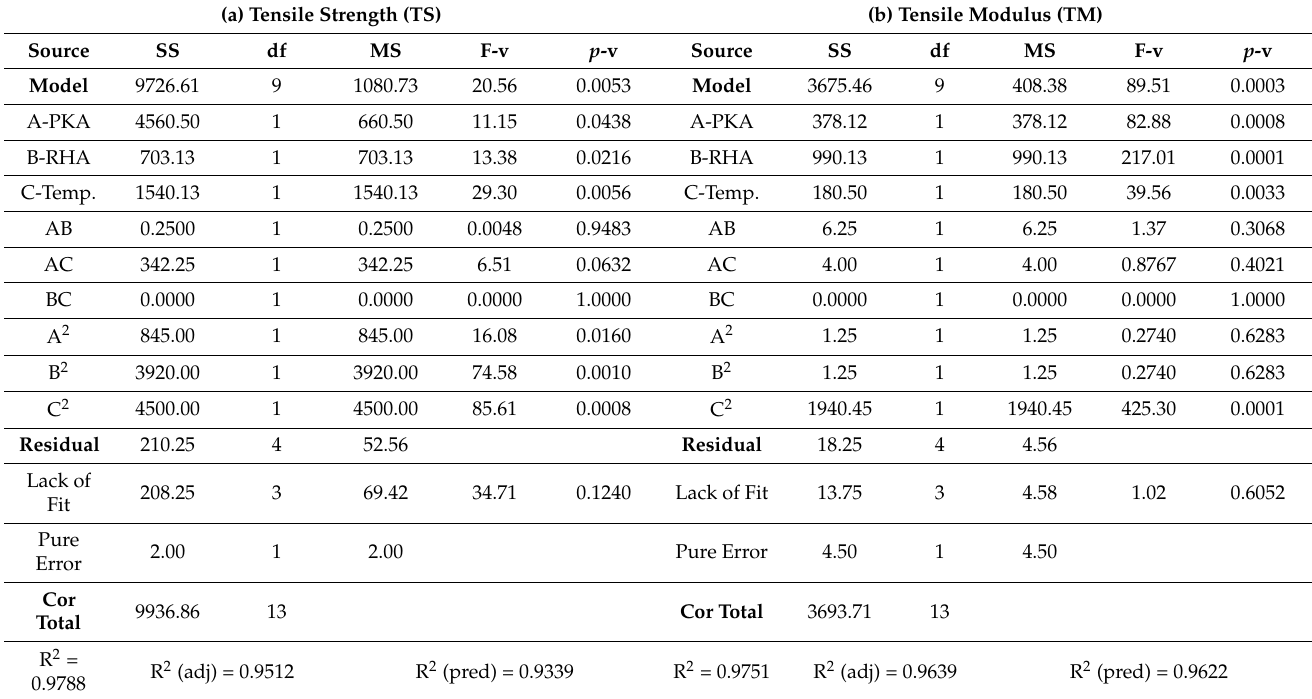
between R 2 (adj) and R 2 (pred) for TS and TM is not above 0.2, there exists an agreement between the two parameters and the models are fit for response prediction. Table 7. Analysis of variance for (a) Tensile strength (b) Tensile modulus.